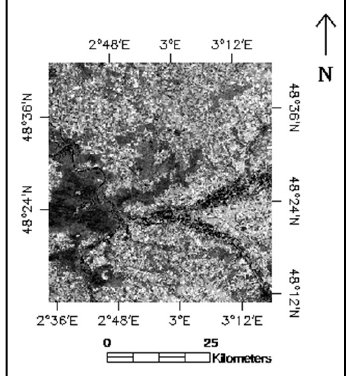
Figure 6. Example of Landsat 8 image product (band 5) produced for Grand Morin Cal/Val location (day 110, 20 April 2015). The output image map projection (Albers Conical Equal Area), image extent, pixel size (250 m), geographic coordinates, and output format, are applicable to all images ordered with the same processing options (Table 2).